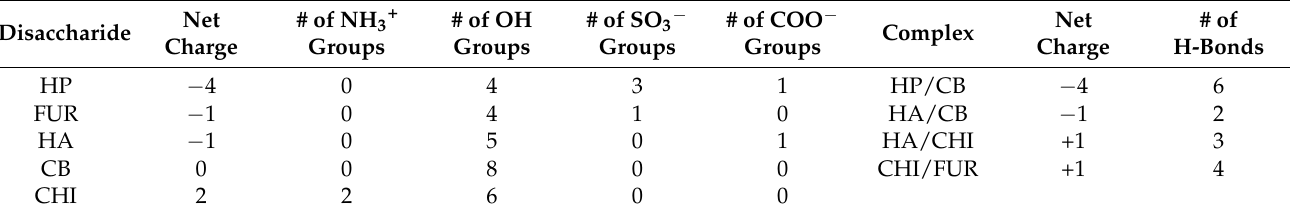
Table 1. Net charges, number of charged and hydroxyl groups, and number of intermolecular hydrogen bonds of the individual disaccharides and their complexes used in this